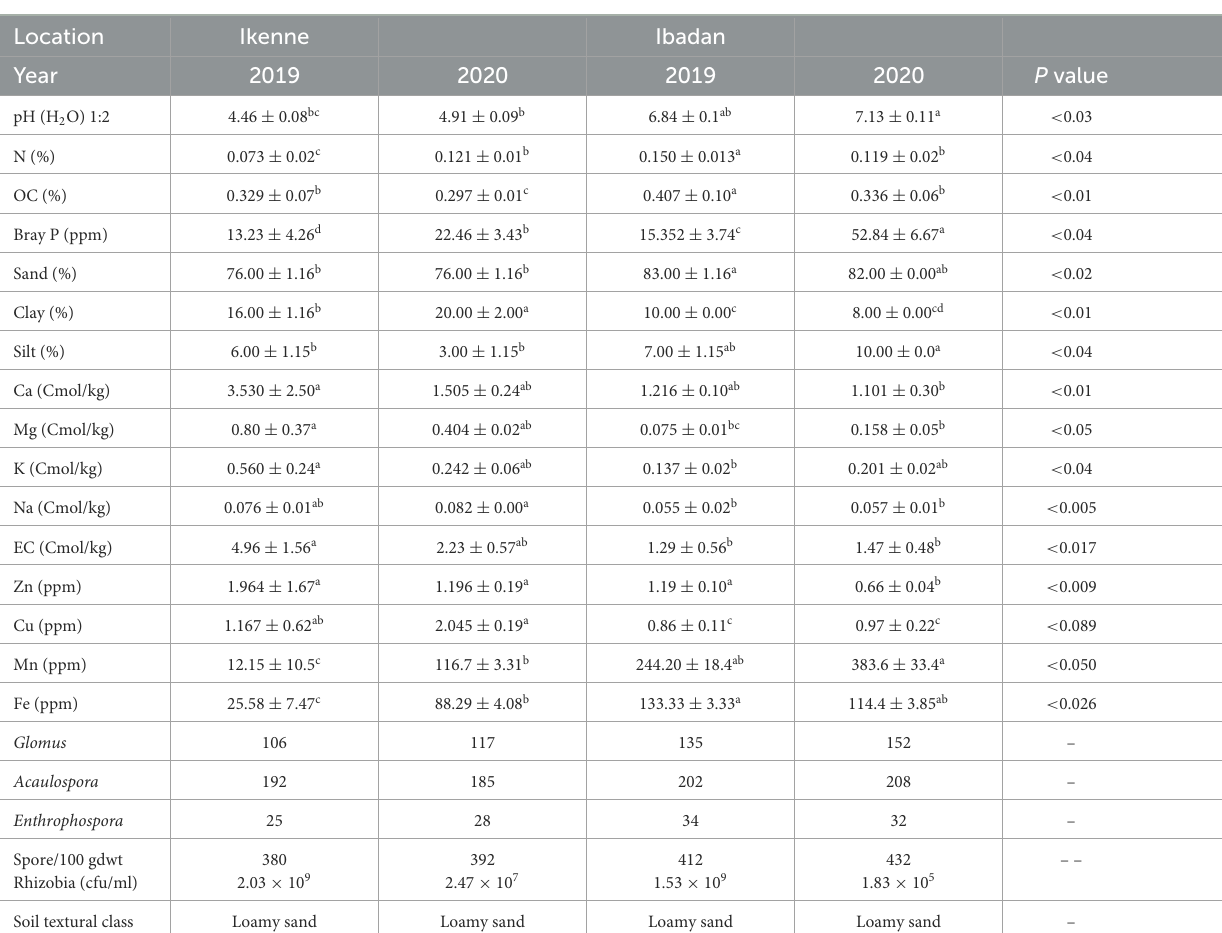
TABLE 2 Physiochemical and biological properties of soil used for the